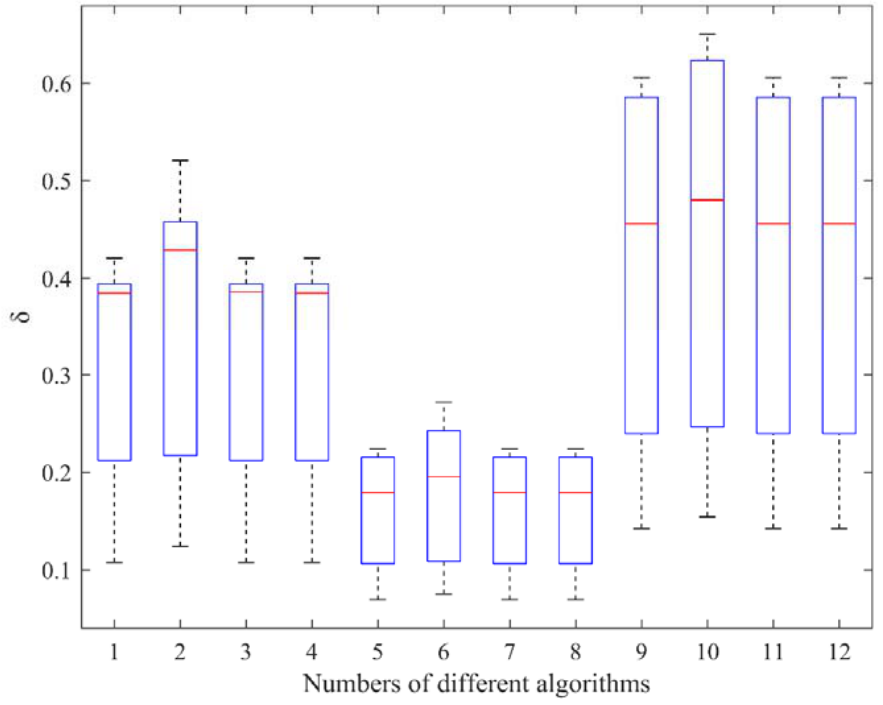
Figure 5. Box ‐ and ‐ whisker plot for average δ deviation from ILCA. Figure 5. Box-and-whisker plot for average δ deviation from